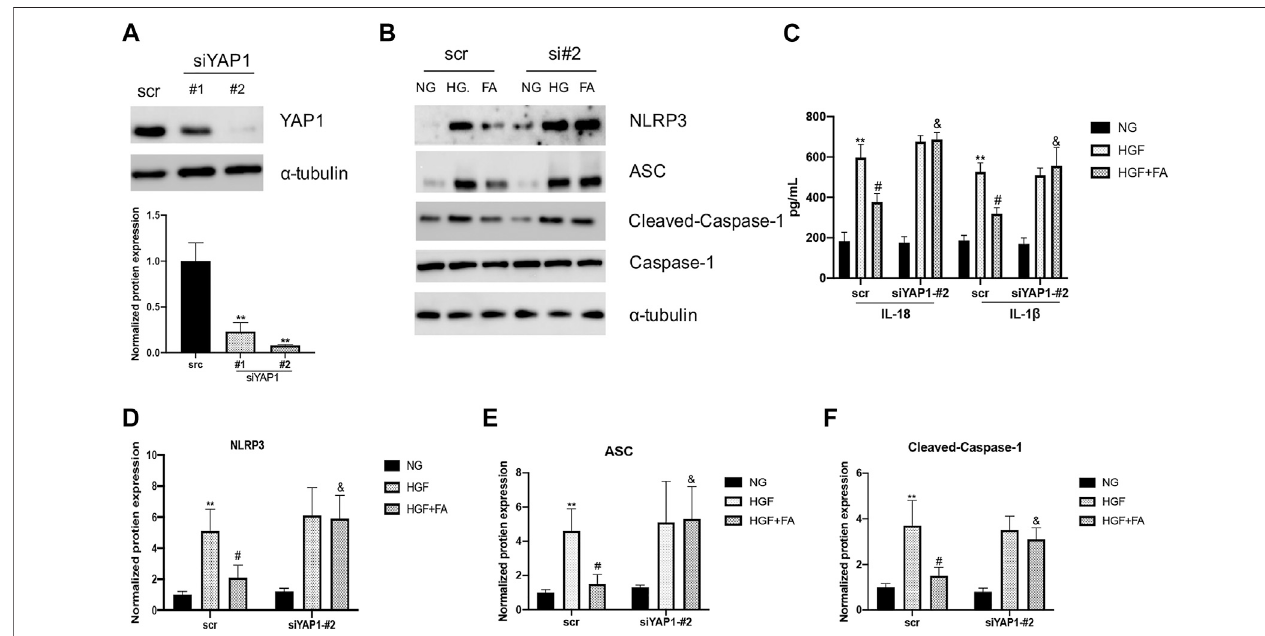
FIGURE6| Theanti-pyroptosisactivityoffolicacidwasdependedonYAP1. (A) siRNAsigni fi cantlyinhibitstheexpressionofYAP1. (B) Representativeimmunoblot levels of NLRP3, ACS, Cleaved-Caspase-1, Caspase-1 in scr and siYAP1 H9C2 cells treated with different medium. (C) IL-1 β and IL-18 levels in the cell supernatant. (D – F) Quanti fi cation of NLRP3, ACS, with α -tubulin as the loading control; for Cleaved-caspase-1, Caspase-1 as the loading control. ** p < 0.01, compared with NG treated scr cells; # p < 0.01, compared with HGF treated scr cells, & p < 0.05, compared with HGF+ 500 nM folic acid treated siYAP1